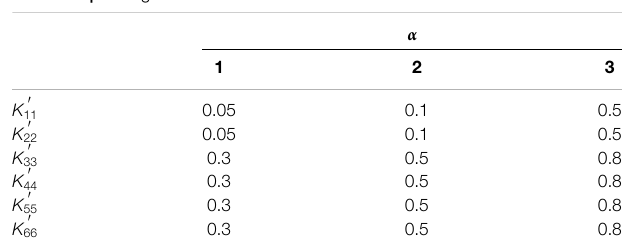
TABLE 1 | scaling factor.